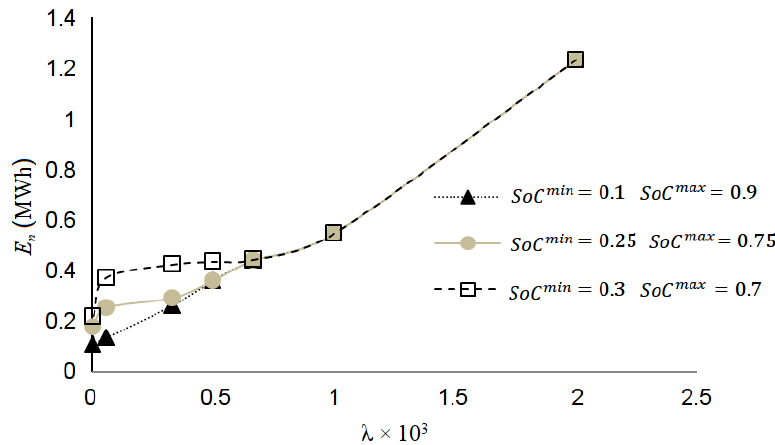
Figure 6. Nominal BEES energy capacity as a function of λ